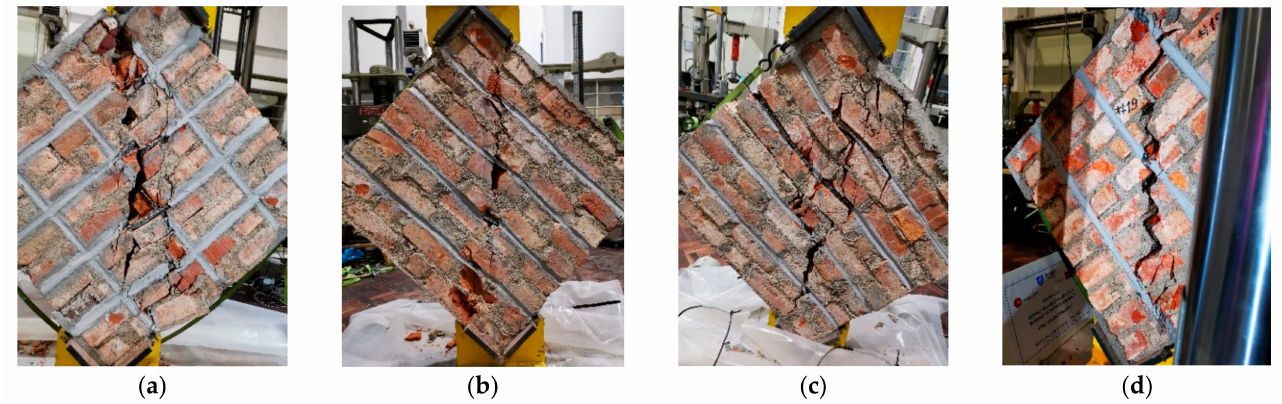
Figure 11. Crack patterns of the wallettes reinforced with TSB in diagonal compression test.